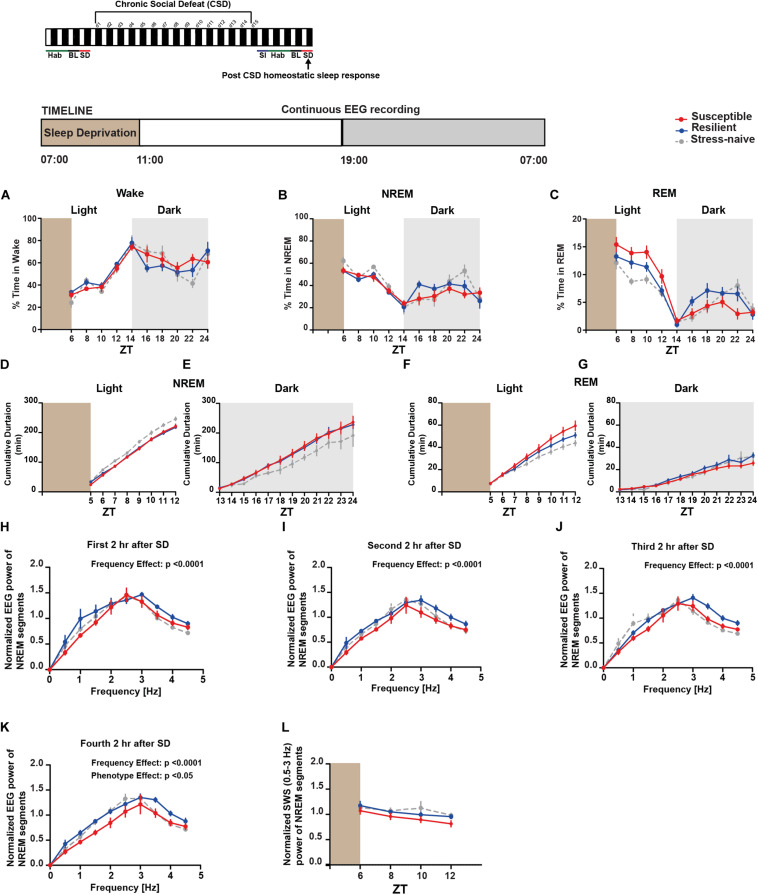
Post-CSD Stress: Aberrant homeostatic sleep response of stress-exposed mice. (A–C) During the light, there was “phenotype” effect in the REM homeostatic sleep response as the susceptible mice spent more time in REM sleep than the resilient and the stress-naïve mice (F2,18 = 6.098, p < 0.01; C). (D) Stress-naive mice exhibited greater average cumulative duration of NREM relative to susceptible and resilient mice (p < 0.05 for both comparisons). (E) Susceptible and resilient mice displayed greater average cumulative duration of NREM during the dark relative to stress-naive (p < 0.05 for both comparisons). (F) Susceptible mice displayed the greatest average cumulative duration of REM, followed by resilient and stress-naïve mice during the light (p < 0.05 for all comparisons). (G) Resilient mice exhibited greater average cumulative duration of REM during the dark relative to susceptible mice (p < 0.05). (H–K) Normalized power spectral analysis of EEG recordings 2, 4, 6, and 8-h after SD. There was a significant effect of within-subjects factor “frequency” on all 4 subfigures (p < 0.0001). (K) There was a “phenotype” effect in the interval (6–8-h) post SD (F2,16 = 3.697, p < 0.05) as susceptible mice displayed lower spectral power in the band (0.5–4.5 Hz) compared to resilient and stress-naïve mice. (L) Repeated measures two-way ANOVA of normalized SWA (0.5–3 Hz) of NREM bouts showed a significant effect of time (F1.732,29.45 = 4.672, p < 0.05). Data are averaged across 2-h intervals. Values are expressed as percentage of total recording time (A–C) or normalized power (H–L) (mean ± sem). n = 6–8 for each group.